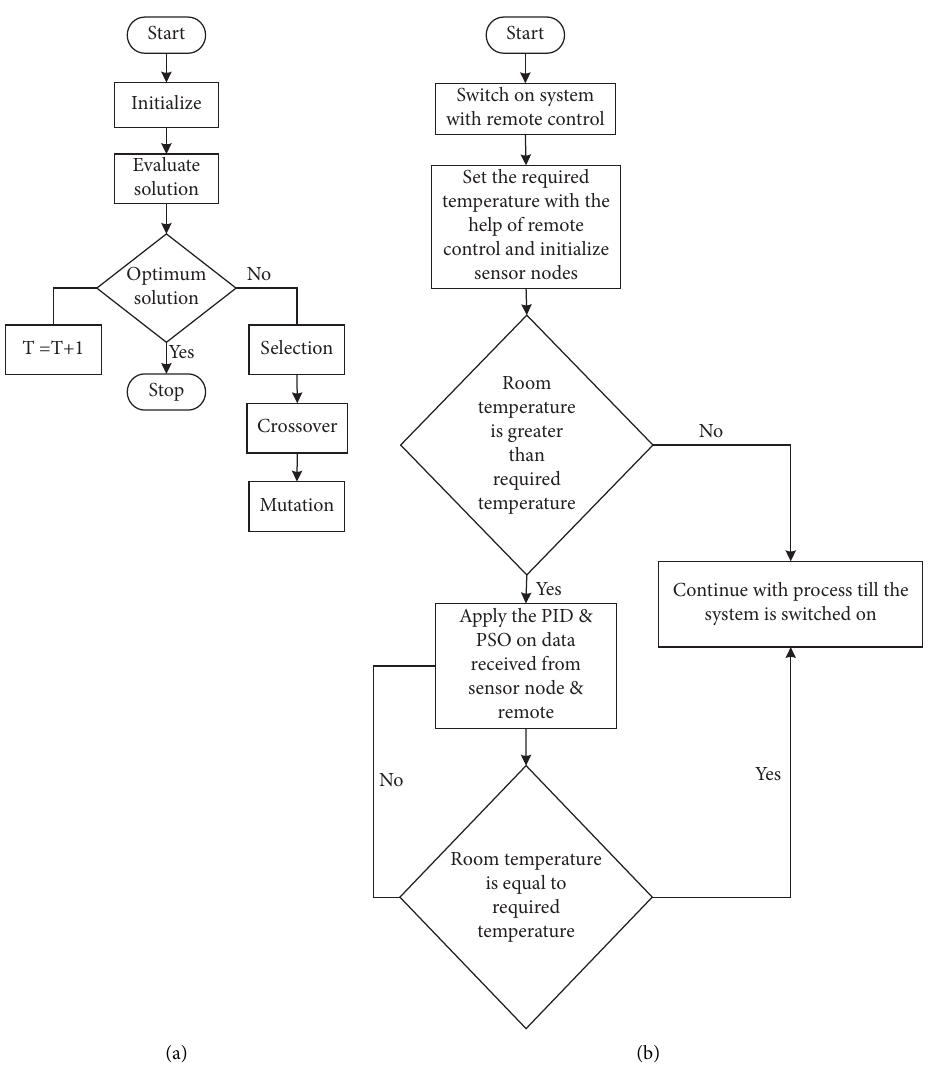
Figure 4: Flowchart for genetic algorithm (a). Flowchart for PSO algorithm (b).